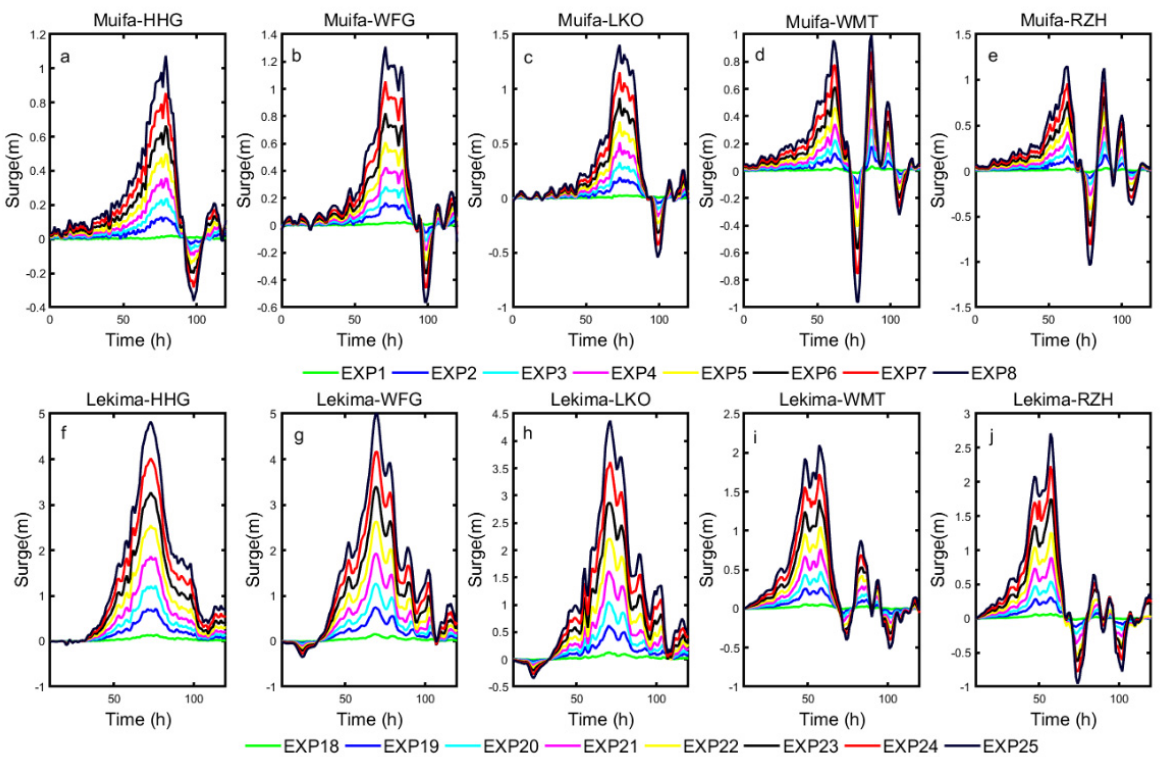
Figure 10. Storm surge associated with the maximum wind speed over time at ( a ) HHG, ( b ) WFG, ( c ) LKO, ( d ) WMT, and ( e ) RZH for Typhoon Muifa and ( f ) HHG, ( g ) WFG, ( h ) LKO, ( i ) WMT, and ( j ) RZH for Typhoon Lekima.